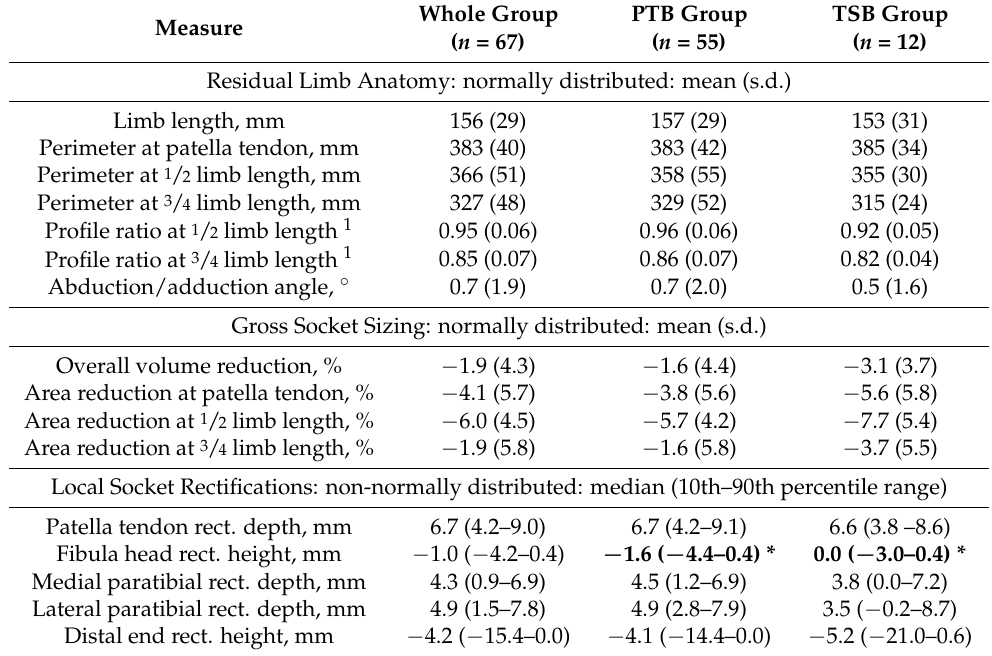
Table 3. Training dataset shape and socket design